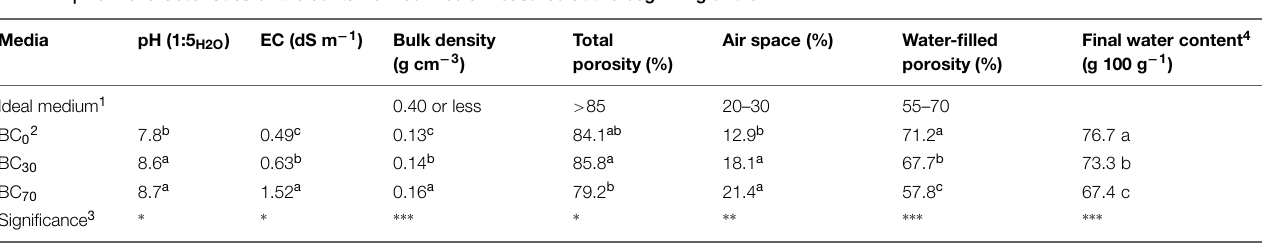
TABLE 2 | Main characteristics of the containerized media measured at the beginning of trial.